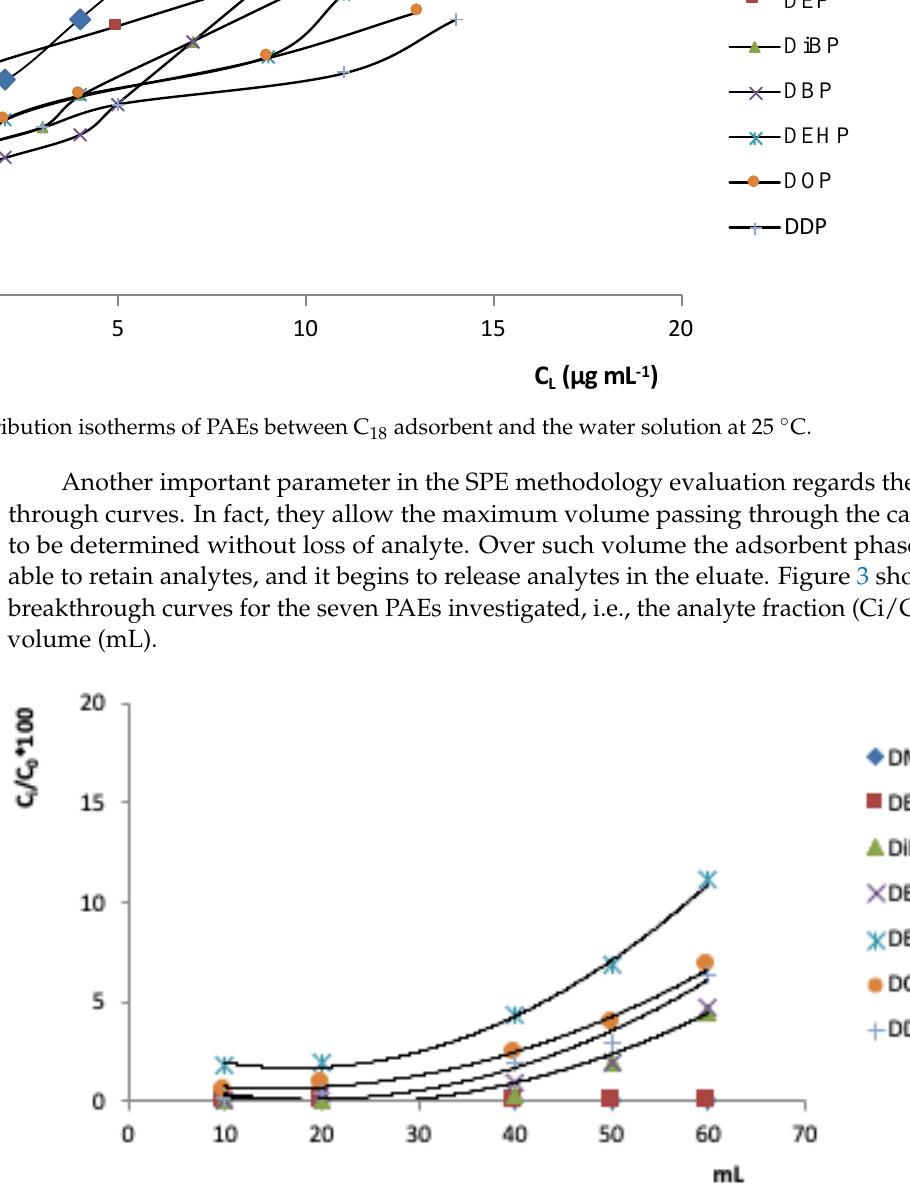
Figure 3. Breakthrough curves of the investigated PAEs in 100 mL solution spiked with 40 µg mL −1 of each analyte on the C 18 cartridge (100 mg).